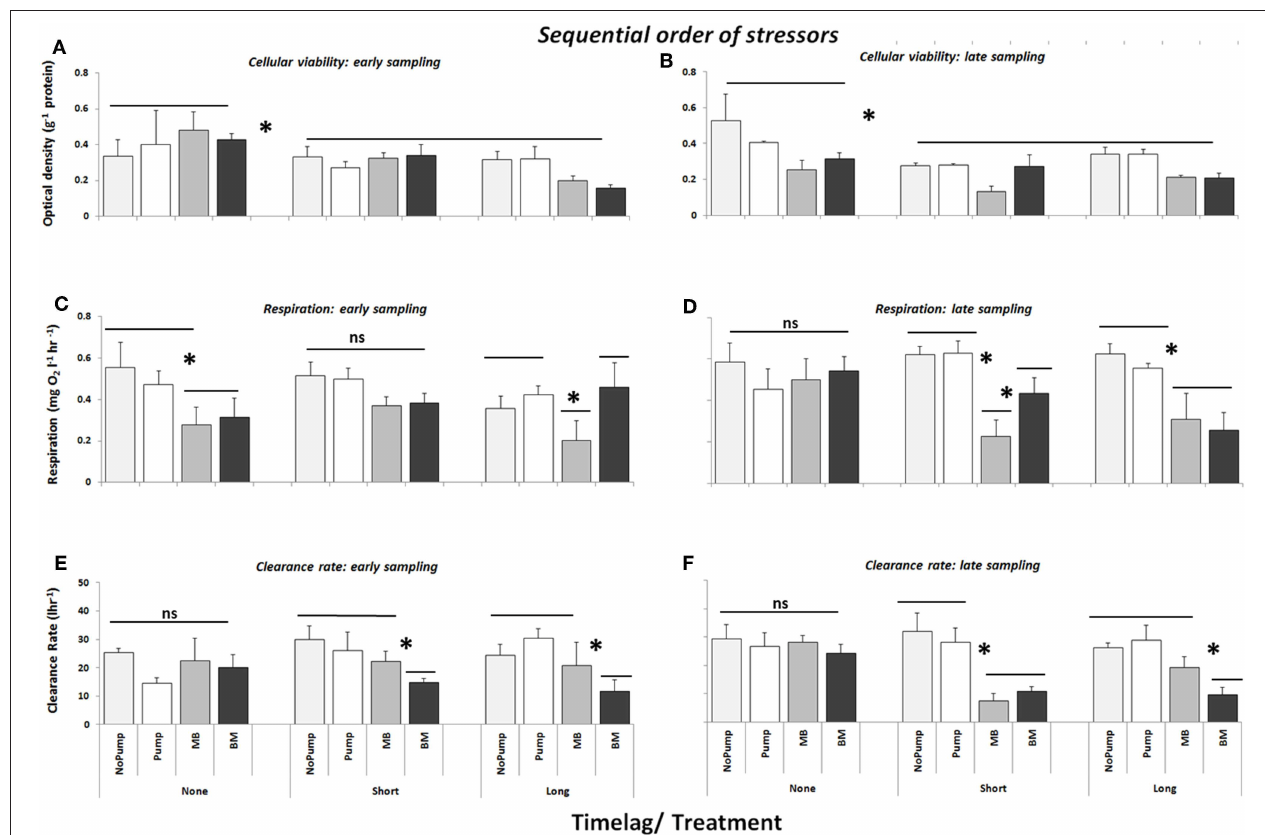
FIGURE 4 | Cellular viability (optical density g − 1 haemocyte protein), respiration (mg O 2 l − 1 hour − 1 ) and clearance rate (l/hour) of mussels/mussel assemblages at Malahide marina testing the sequential order of arrival of multiple stressors (i.e., MB vs. BM, where B = Biocide and M = Copper). Also shown are the control treatments: “No Pump” (an un-manipulated control) and “Pump” (a procedural control). All treatments were subject to three time-lag treatments (None, Short and Long) between the arrival of the first stress event and the second stress event and were sampled directly after dosing (Early– A,C,E ) and 2 weeks after dosing (Late– B,D,F ) ( n = 3). Asterisks indicate significant differences between individual and/or groups of treatments.